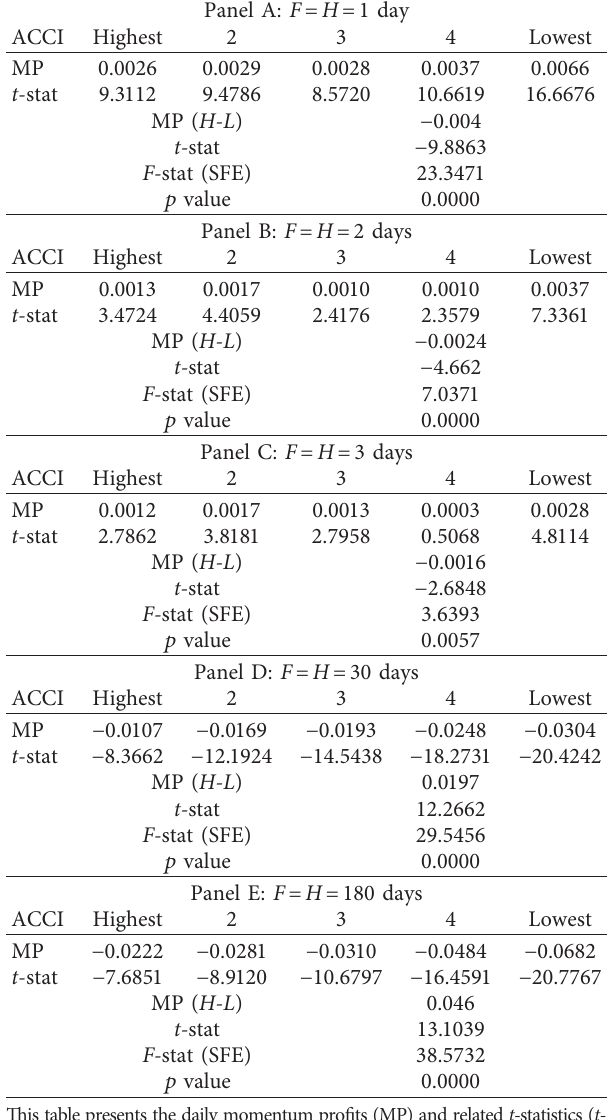
Table 3: The effect of the accumulative relative order imbalance of the A-share